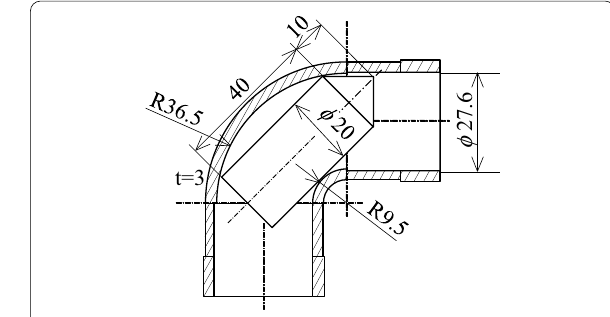
Fig. 4 Cross section of an elbow part of 25A pipe